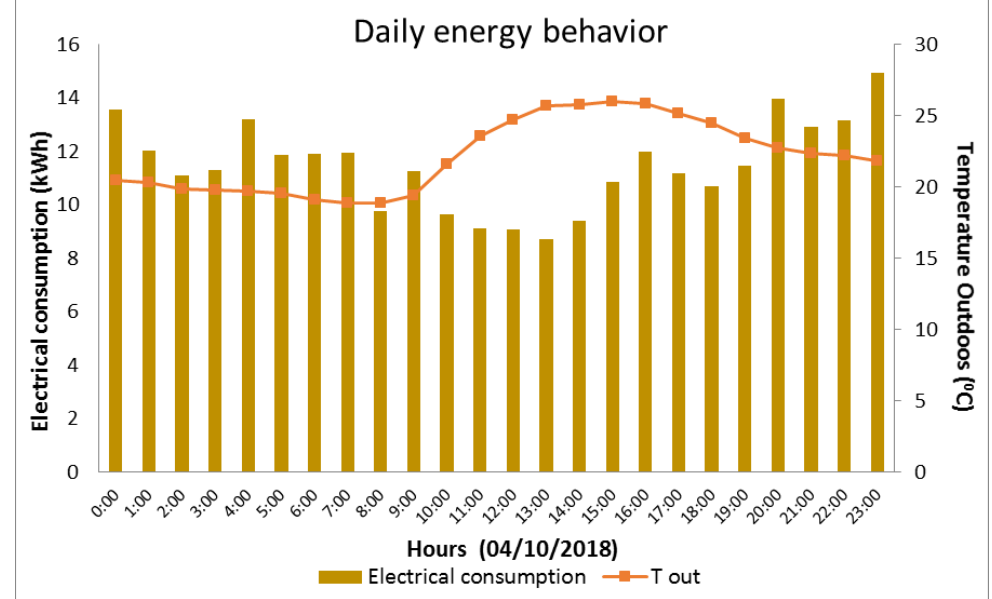
Figure 9. Hourly electrical consumption along with ambient temperature levels.